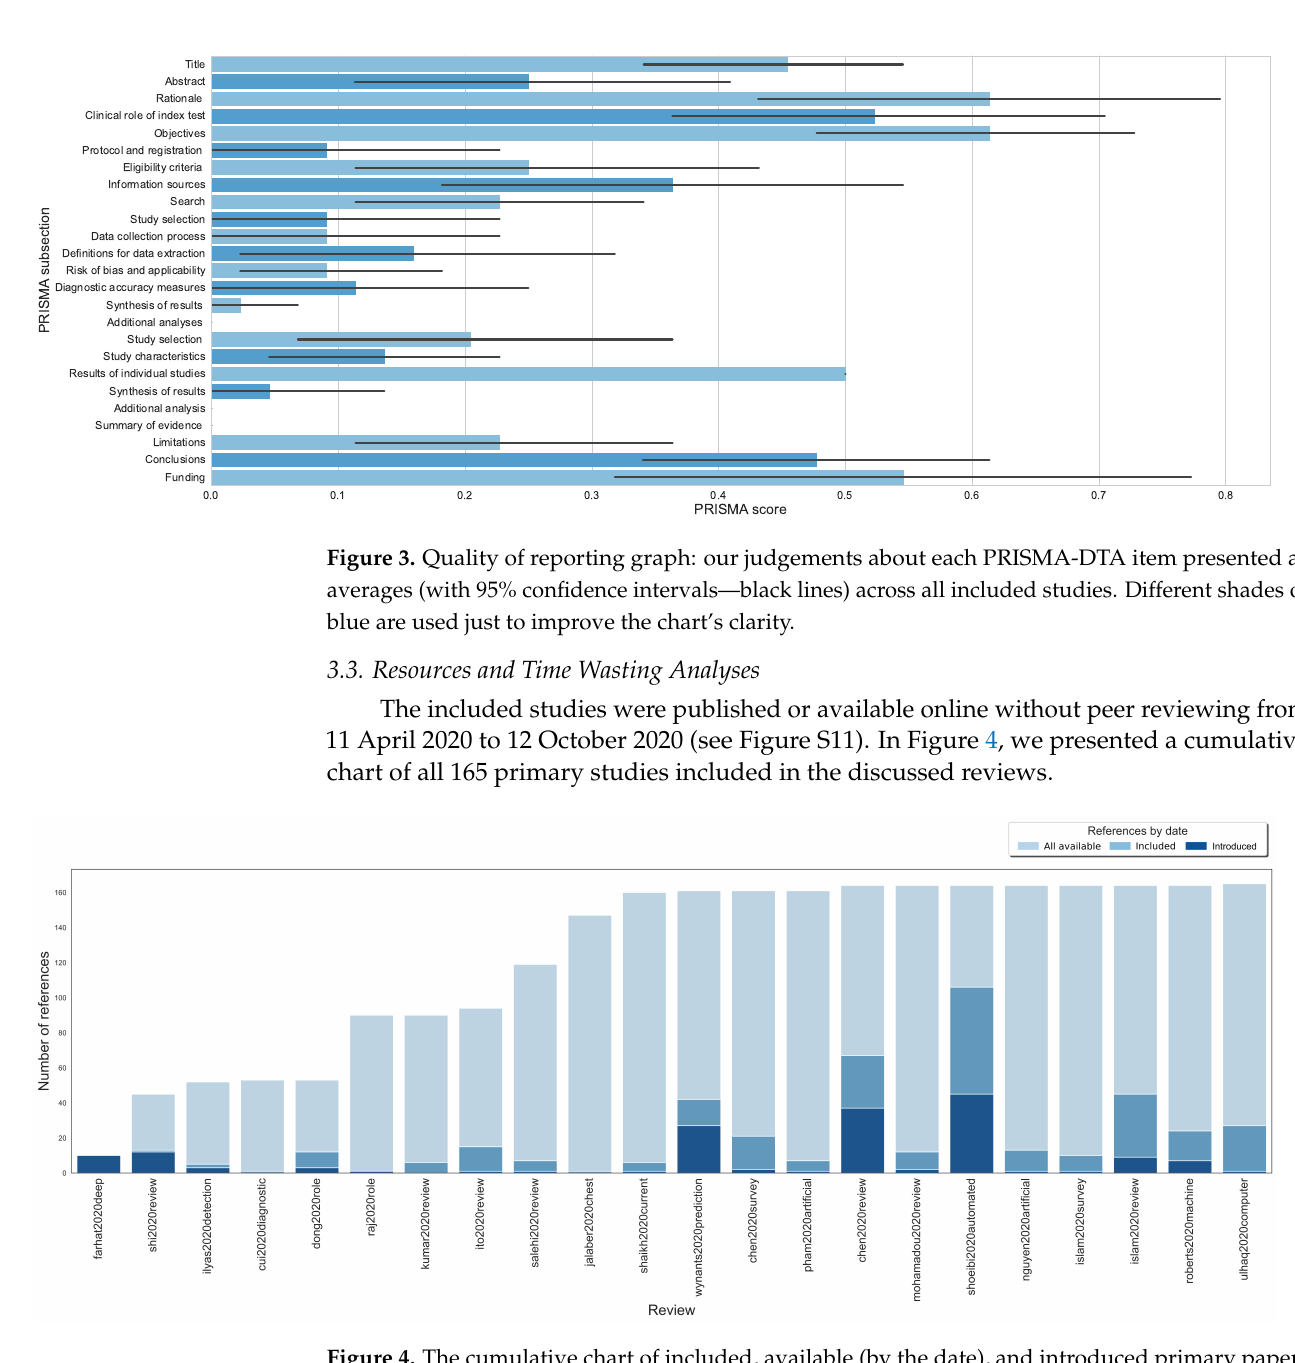
Figure 4. The cumulative chart of included, available (by the date), and introduced primary papers among discussed